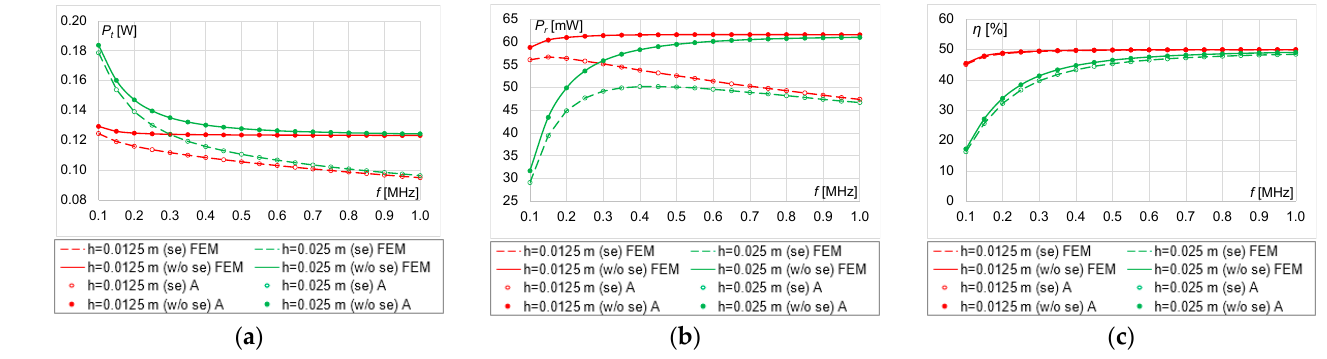
Figure 22. Results for n = 60 for the cases with and without skin effect: ( a ) P t , ( b ) P r , ( c ) η .